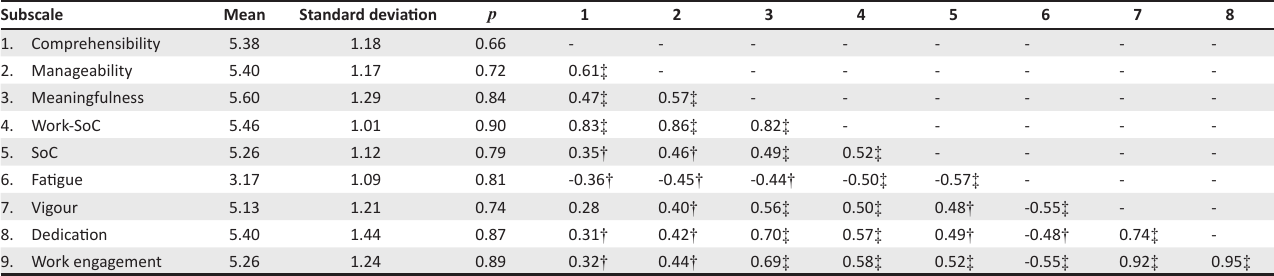
TABLE 3: Descriptive statistics, composite reliabilities and Pearson correlations of the subscales and scales of Work-SoC, SoC, fatigue and work engagement. Subscale Mean